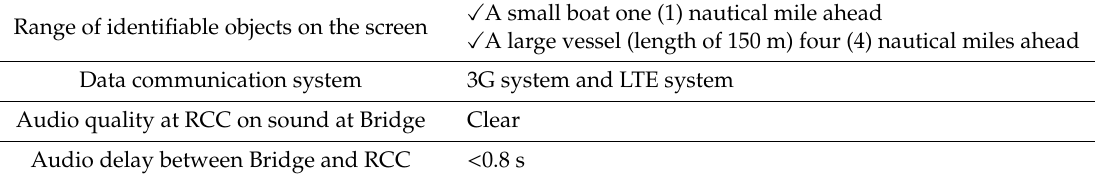
Table 1. Visual condition on the screen at Remote Control Centre (RCC) and sound condition that Remote Operator (RO) can hear at RCC. Factor Condition Viewing angle of screen 360 ◦ Screen resolution 1500 × 300 (pixel) Visual Intermittency of screen 5~10 s / h (Completely recover in 30 s) Visibility of screen Clear (Clear weather) Delay of video on the screen < 0.1 s between Bridge and RCC (cid:88) A small boat one (1) nautical mile ahead Range of identifiable objects on the screen (cid:88) A large vessel (length of 150 m) four (4) nautical miles ahead Data communication system 3G system and LTE system Audio quality at RCC on sound at Bridge Clear Audio delay between Bridge and